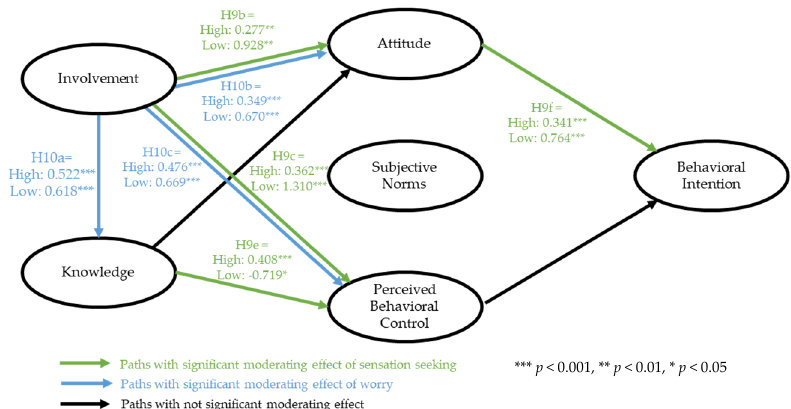
Figure 3. Conceptual model and multigroup invariance test results.